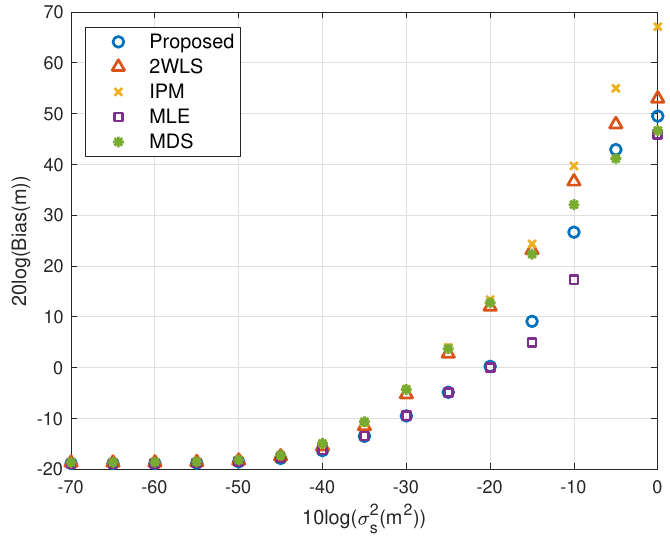
Figure 6. MSE performance as error level increasing (near source, 4 sensors).